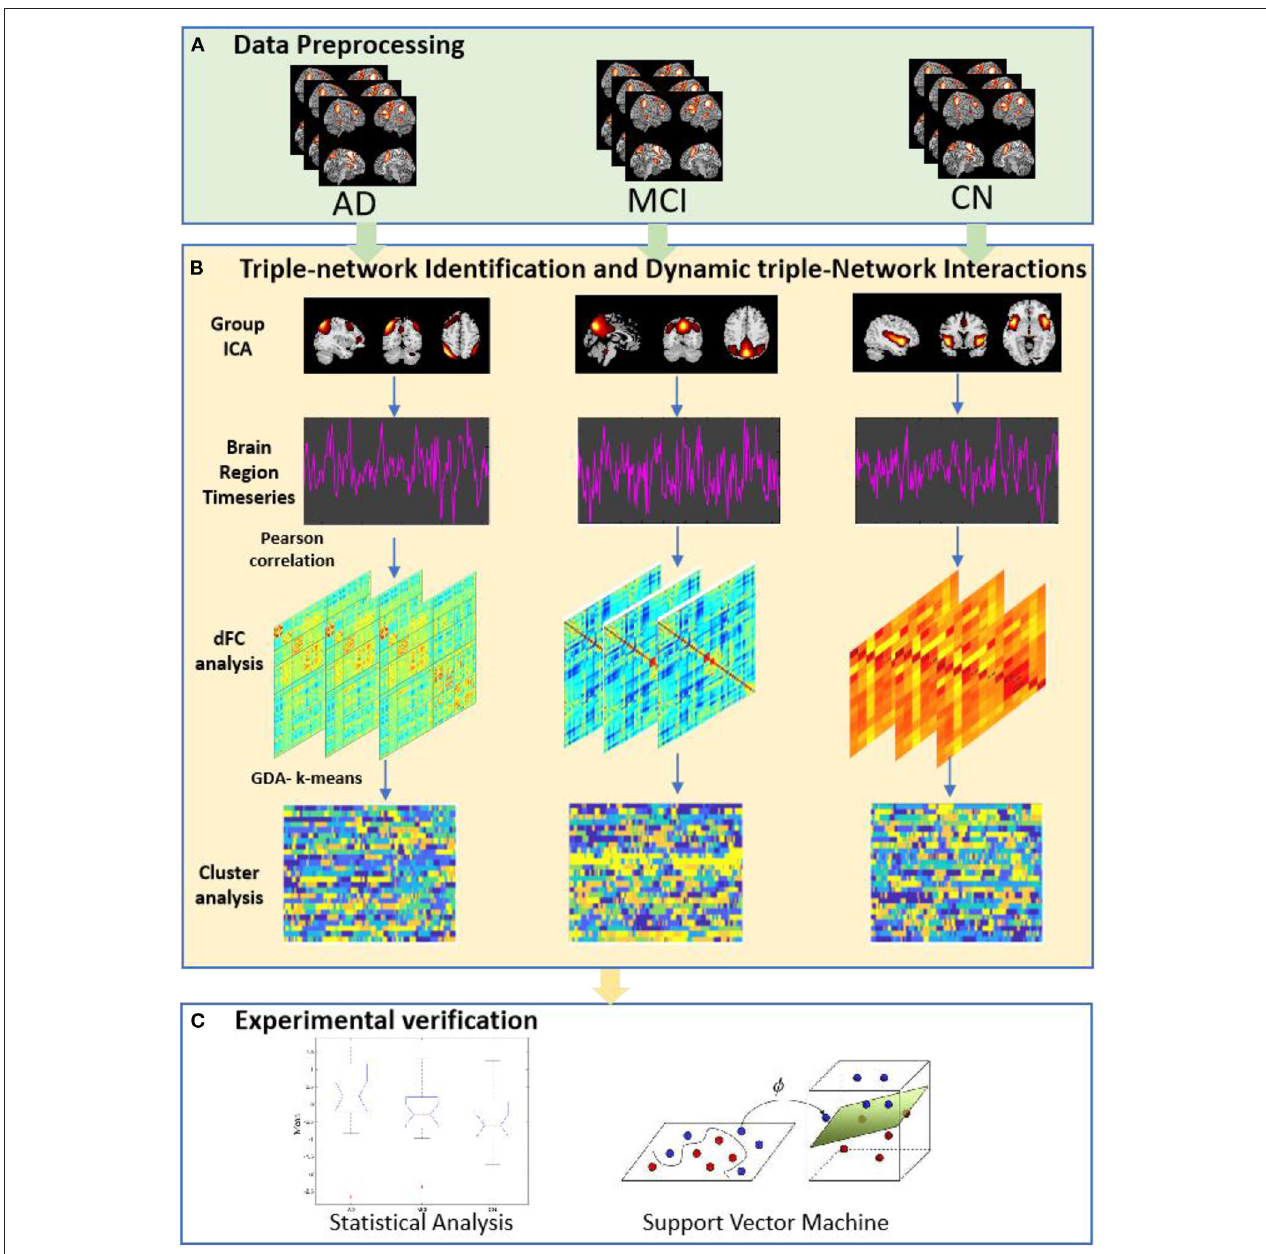
FIGURE 1 | The study workflow. (A) Data Preprocessing, 145 rs-fMRI data were preprocessing. (B) Triple-network Identification and Dynamic Triple-Network Interactions. At this stage, group independent component was achieved; dynamic functional interactions were using a sliding window approach; cluster analysis based on k-means clustering method. (C) Experimental verification, were used statistical analysis and support vector machine approach.